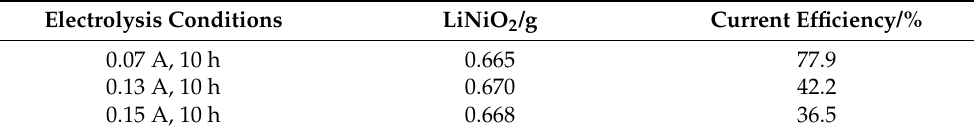
Table 1. 10 h electrolysis efficiency at 750 °C at 0.07–0.15 A. Electrolysis Conditions